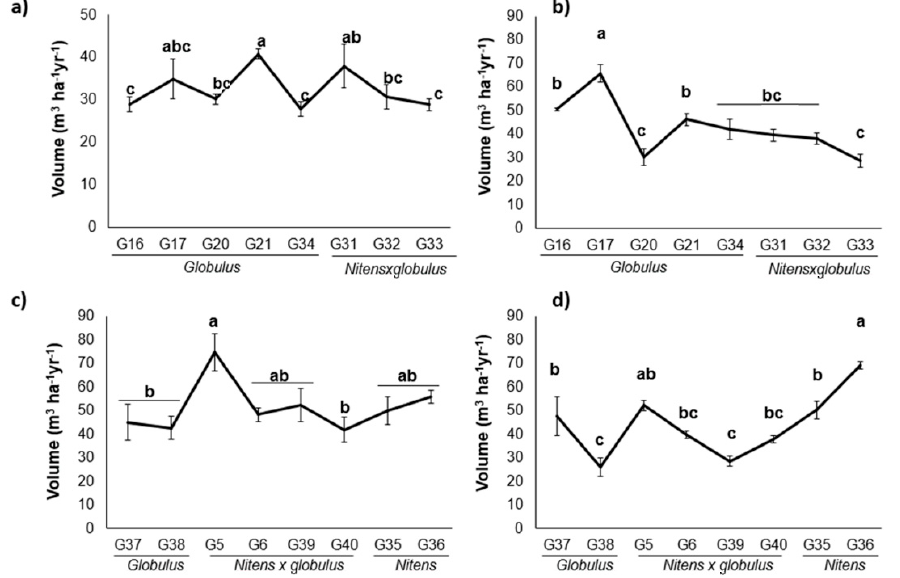
Figure 2. Average annual volume growth (m 3 ha − 1 year − 1 ) of each genotype by taxa at sites: ( a ) Los Patos ( b ) Vegas de Saldia North, ( c ) El Derrumbe, and ( d ) San Andrés from 2017 to 2018.